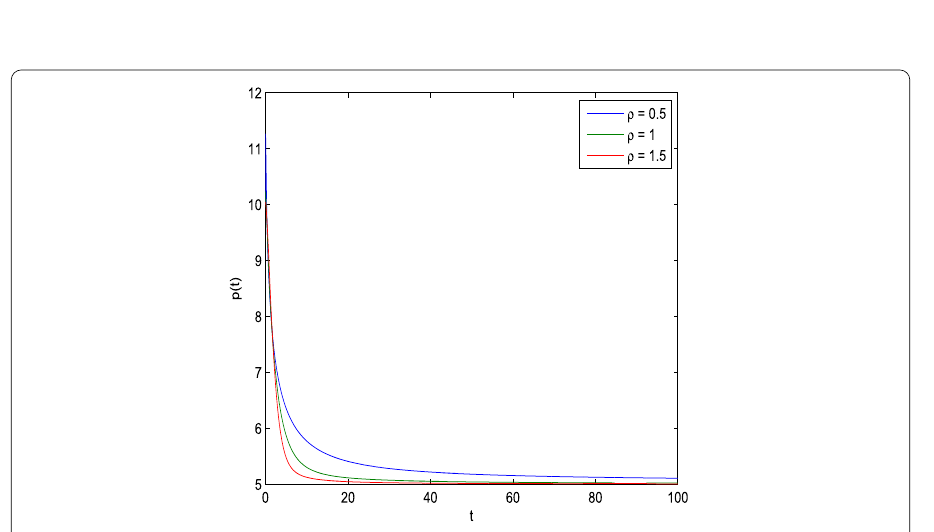
Figure 2 The approximate values of p ( t ) for the perturbed basic cobweb model, Example 1, at various values of ρ and α =